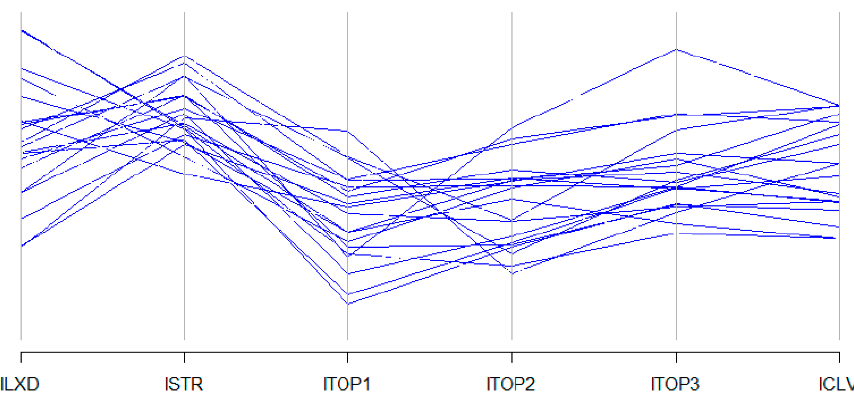
Figure 4. With the data in Figure 3, texts belong to the first quartile of l CLV, R package MASS .